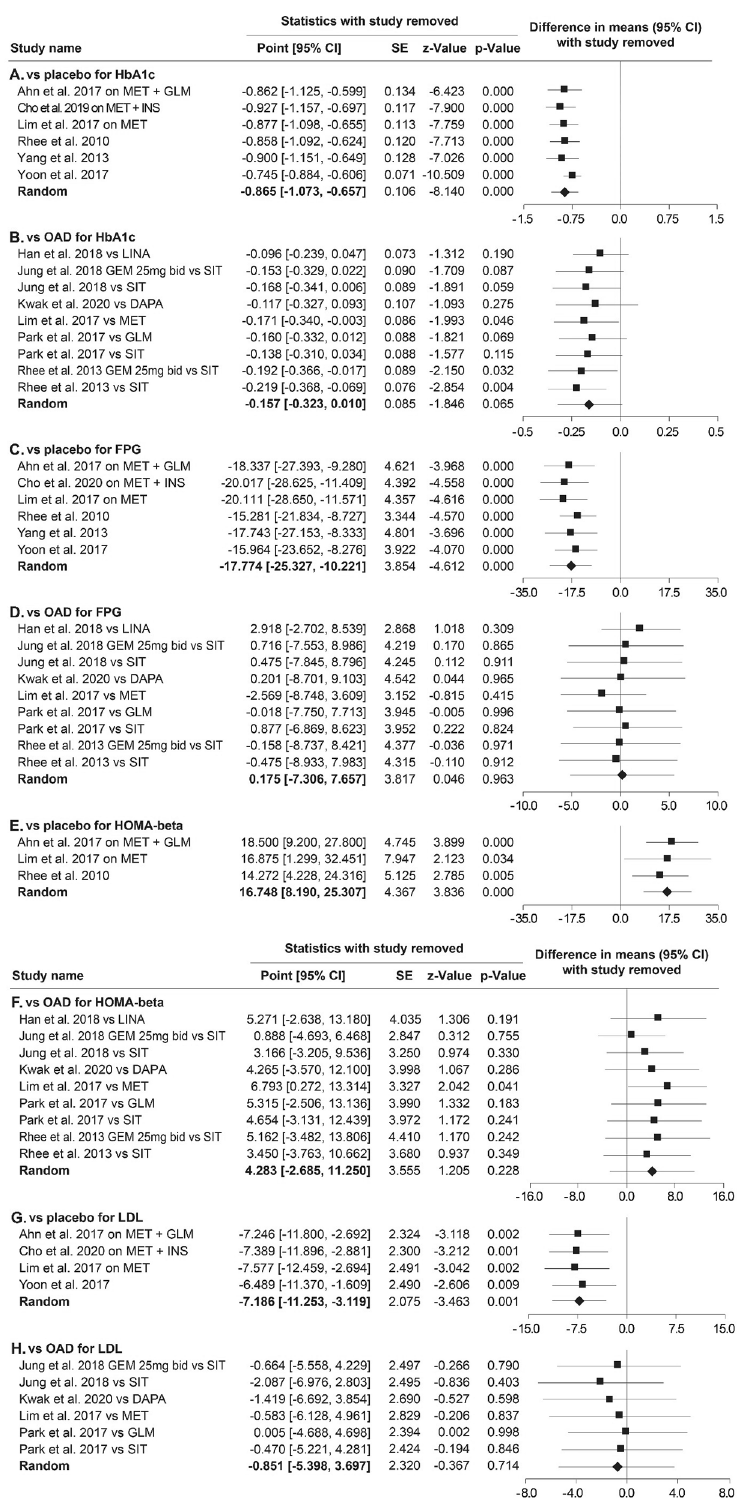
Figure 8. Sensitivity analysis of the studies examined for HbA1c, FPG, HOMA-β, and